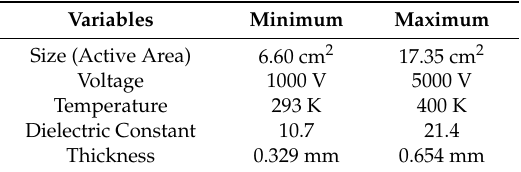
Table 4. Sensitivity Analysis Variables and Ranges.